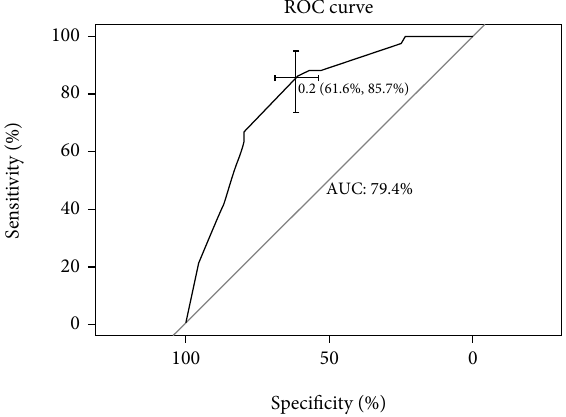
Figure 2: ROC curve of the developed